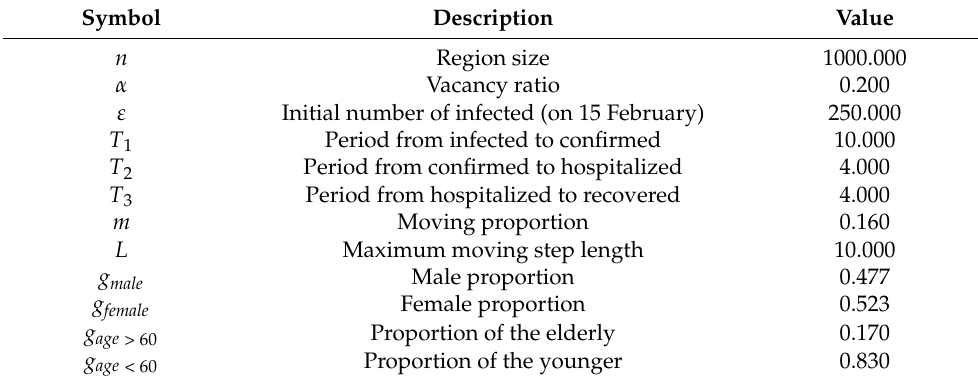
Table A1. The parameters set for NYC.